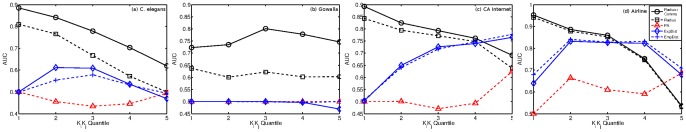
AUC measured over separate quantiles of the test data, split by the combined degrees of the nodes for which a link is being predicted,

. The quantiles are shown on the x-axis, where 1 contains all node-pairs in which both nodes have low degree and 5 contains those in which both nodes have very high degrees.